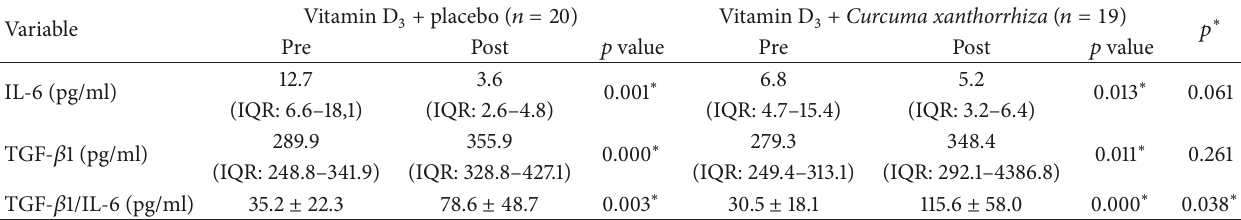
Table 3: Effects of C. xanthorrhiza supplementation on vitamin D 3 administration towards cytokine levels.